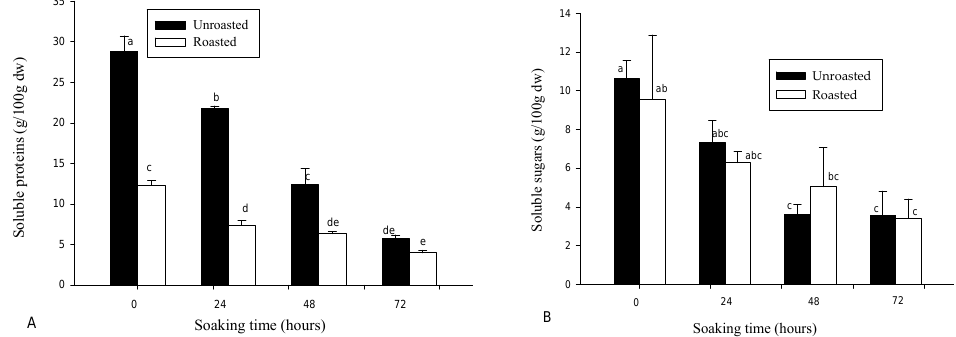
Figure 3. ( A ) Soluble protein; and ( B ) Soluble sugar contents of soybean flour, as affected by soaking time and roasting. Bars bearing different letters are significantly different at p < 0.05; n = 3.